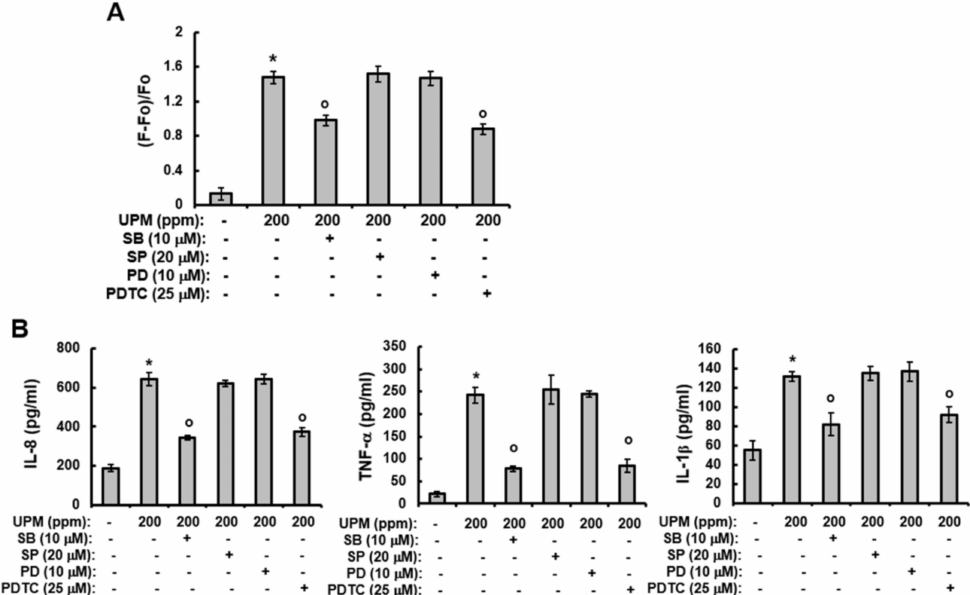
Figure 5. UPM-induced increases in Ca 2+ influx and production of pro-inflammatory cytokines is mediated through activation of p38 MAPK and NF- κ B. ( A ) HaCaT cells were loaded with Fura2-AM for 60 min and then washed with Krebs-HEPES buffer for the [Ca 2+ ] i measurement. The [Ca 2+ ] i was measured fluorometrically every 5 s for 100 sec after the addition of 200 ppm UPM as described in the Materials and Methods. The curve shown is representative of three independent experiments. ( B ) HaCaT cells were treated with UPM (200 ppm) and then incubated for two days in the presence of the indicated concentration of inhibitors. The supernatants were then analyzed using the Multi-Target Sandwich ELISA Kits for IL-8, TNF- α , and IL-1 β . The results were verified using three independent experiments, each of which was conducted in duplicate. * p < 0.05 vs. the untreated control, o p < 0.05 vs. the UPM-treated control. The data are expressed as the mean ± SD. UPM, urban particulate matter; SB, SB203580; SP, SP600125; PD, PD98059; PDTC, ammonium